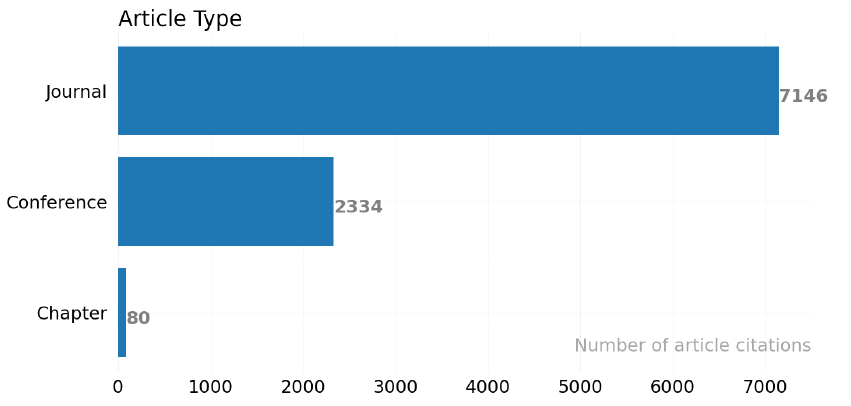
Figure 16. Article classification by venue